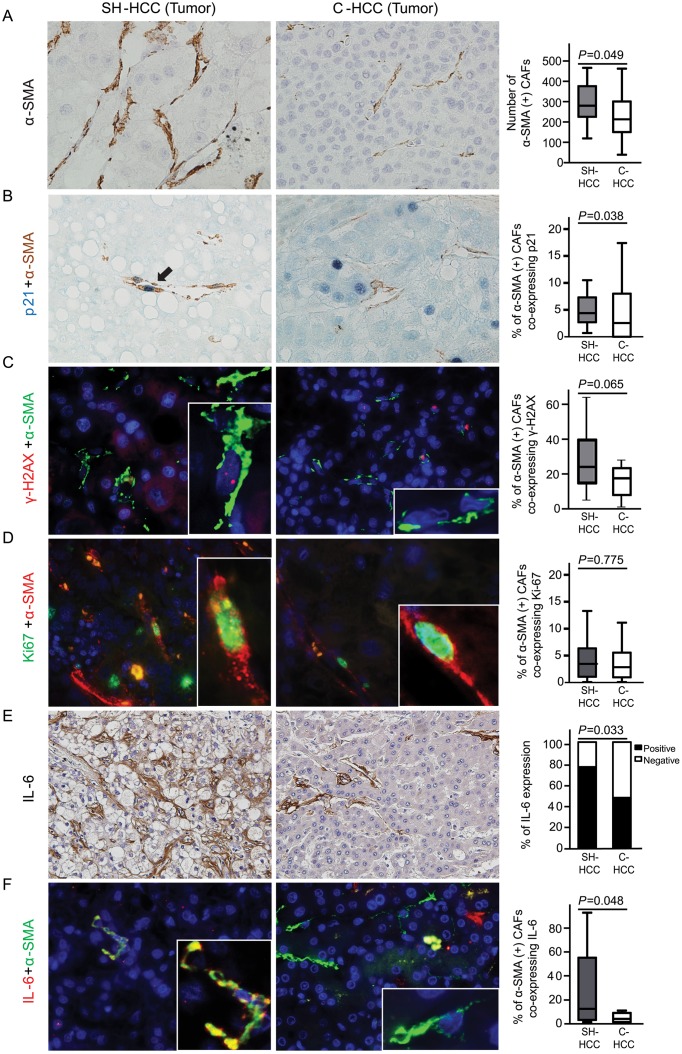
Cancer-associated fibroblasts (CAFs) expressing p21Waf1/Cip1, γ-H2AX, and IL-6 in tumoral regions of steatohepatitic hepatocellular carcinomas (SH-HCCs) and conventional HCCs (C-HCCs).A) CAFs expressing α-SMA are more frequently found in SH-HCCs than in C-HCCs. B) Double immunohistochemical stain demonstrates nuclear p21Waf1/Cip1 in blue and cytoplasmic α-SMA in brown. CAFs co-expressing p21Waf1/Cip1 and α-SMA are more frequently seen in SH-HCCs than in C-HCCs. (C) Double immunofluorescence images of γ-H2AX (red) and α-SMA (green). CAFs co-expressing γ-H2AX and α-SMA are relatively higher in SH-HCCs than in C-HCCs. (D) Double immunofluorescence images of Ki-67 (green) and α-SMA (red). There is no difference between groups. (E) Greater expression of IL-6, detected by immunohistochemistry, in SH-HCCs than in C-HCCs. (F) Double immunofluorescence of IL-6 (red) and α-SMA (green). Nuclei were stained with DAPI. CAFs co-expressing IL-6 and α-SMA are significantly more abundant in SH-HCCs than in C-HCCs. The merged fluorescence images of boxed areas are further magnified in the insets. Box plot graphs in the right column demonstrate comparisons between the two groups (A-D, F, original magnification x400; E, original magnification x200). α-SMA, α-smooth muscle actin.